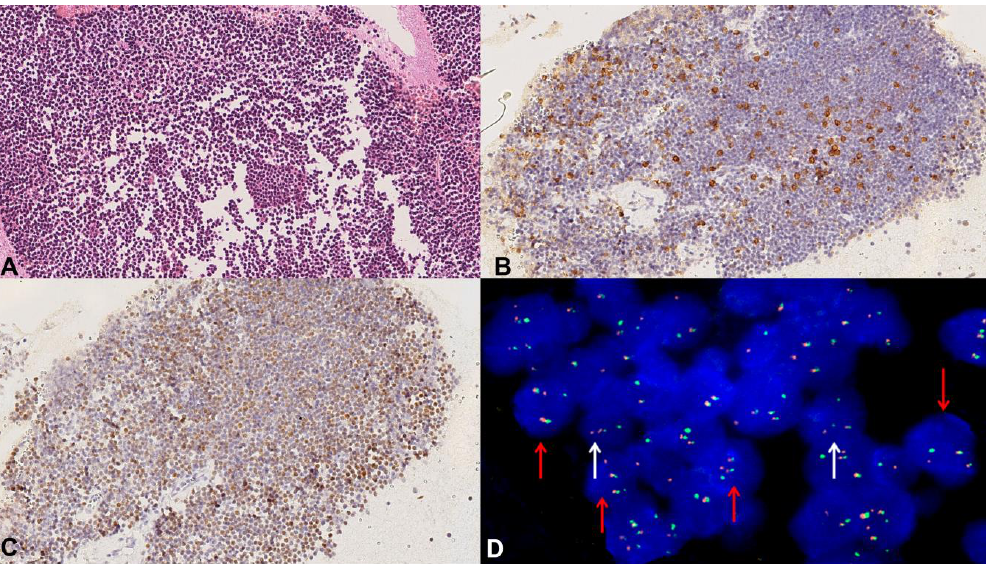
Figure 6. Mantle Cell lymphoma, case 20. Hematoxylin – Eosin CB-stained section shows small monomorphic lymphocytes (20×) ( A ). CD5 stains small lymphocytes (20×) ( B ). CyclinD1 expression in neoplastic cells (20×) ( C ). FISH analysis showing the t(11;14)(q13; q32) translocation. The red arrow indicates neoplastic cells containing single red and green signals (corresponding to the normal CCND1 and IGH loci, respectively) together with two fused signals (corresponding to the genes fused by the translocation). Normal cells are indicated by the white arrow ( D ).